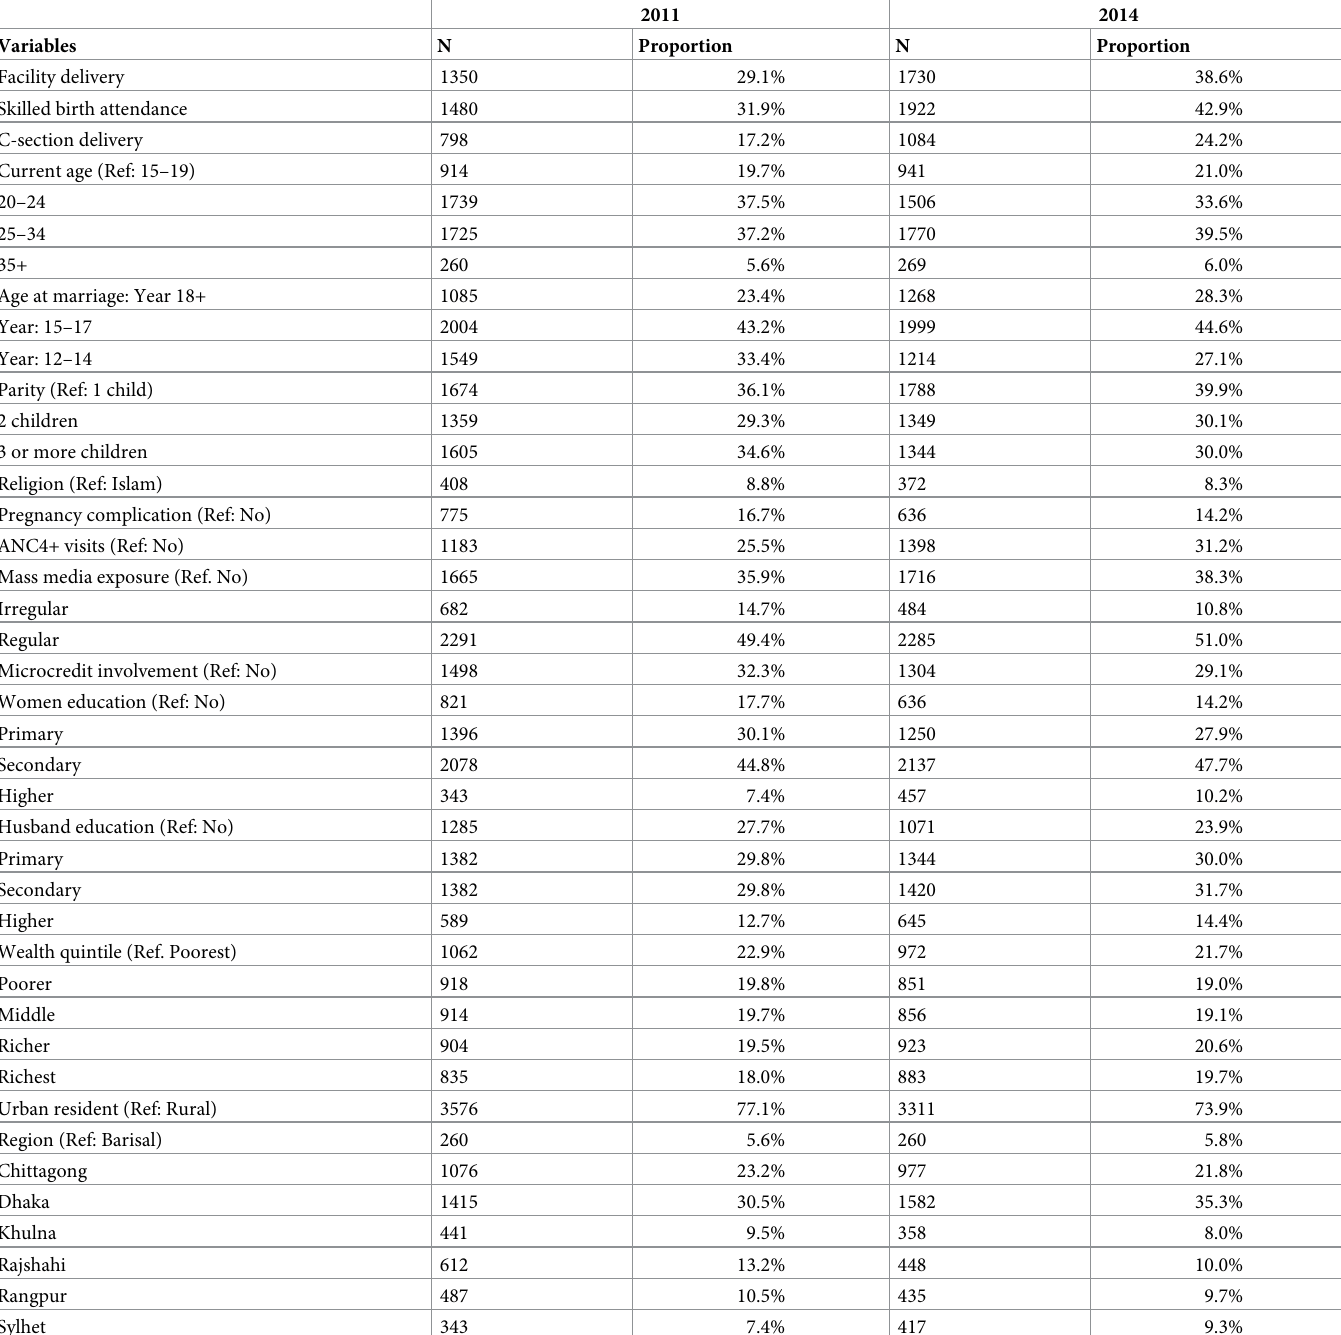
Table 1. Weighted distribution of respondents by selected background